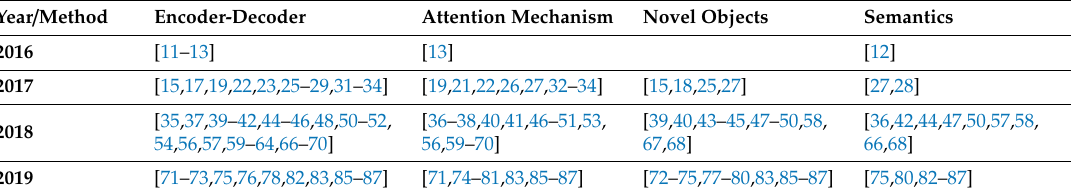
Table 10. Methods used by